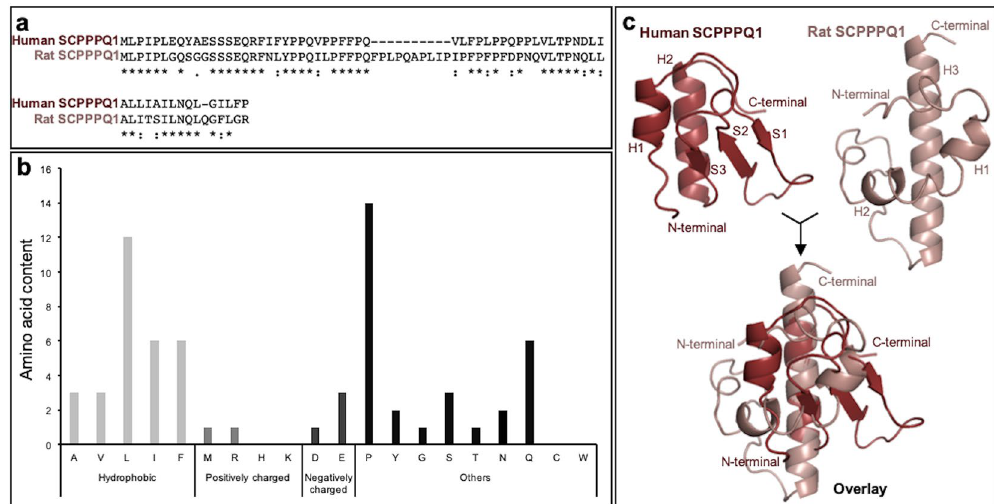
Figure 1. Characterization of the human SCPPPQ1 amino acid sequence. ( a ) Comparison of synthetic human and rat SCPPPQ1 amino acid sequences using MUSCLE. Sequence similarity is indicated as follow: (*) identical residue (single, fully conserved), (:) conserved substitutions (strong similar properties), and (.) semi-conserved substitutions (weak similar properties). ( b ) In silico analysis of the human SCPPPQ1 protein using the APD3 software provided information on the distribution and relative percentage of amino acids with hydrophobic properties, positive and negative charge, and other amino acids. ( c ) Tridimensional structure model from i-TASSER structure prediction software for human (red) and rat (pink) SCPPPQ1 proteins and their overlay. Secondary structure elements are included (H Helix, S Sheet) and labeled according to their position in the structure (H1 to H3, S1 to